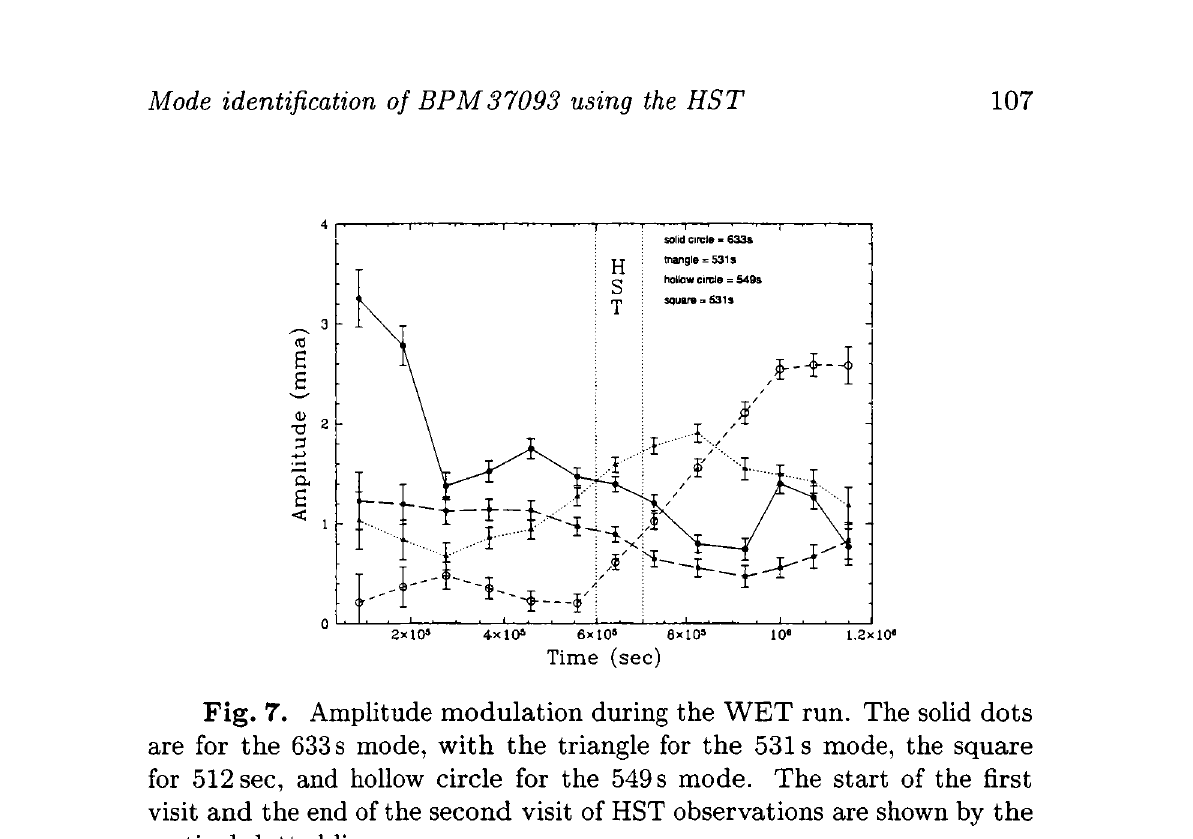
Fig. 7. Amplitude modulation during the W ET run. The solid dots are for the 633 s mode, with the triangle for the 531s mode, the square for 512 sec, and hollow circle for the 549 s mode. The start of the first visit and the end of the second visit of HST observations are shown by the vertical dotted